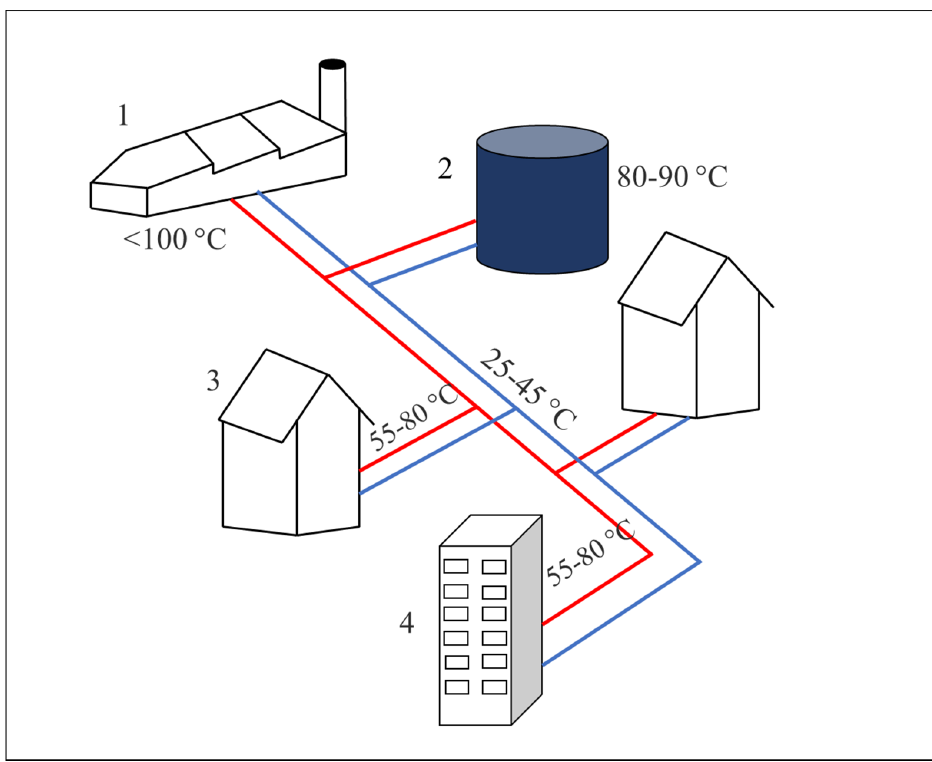
Figure 9. District heating and cooling with centralized storage (1—generation plant, 2—TES, 3,4—DH users).